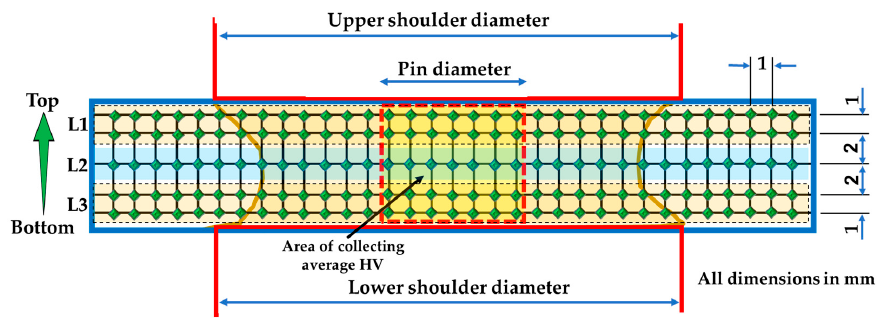
Figure 5. Schematic drawing of the indentation locations to perform hardness measurements.